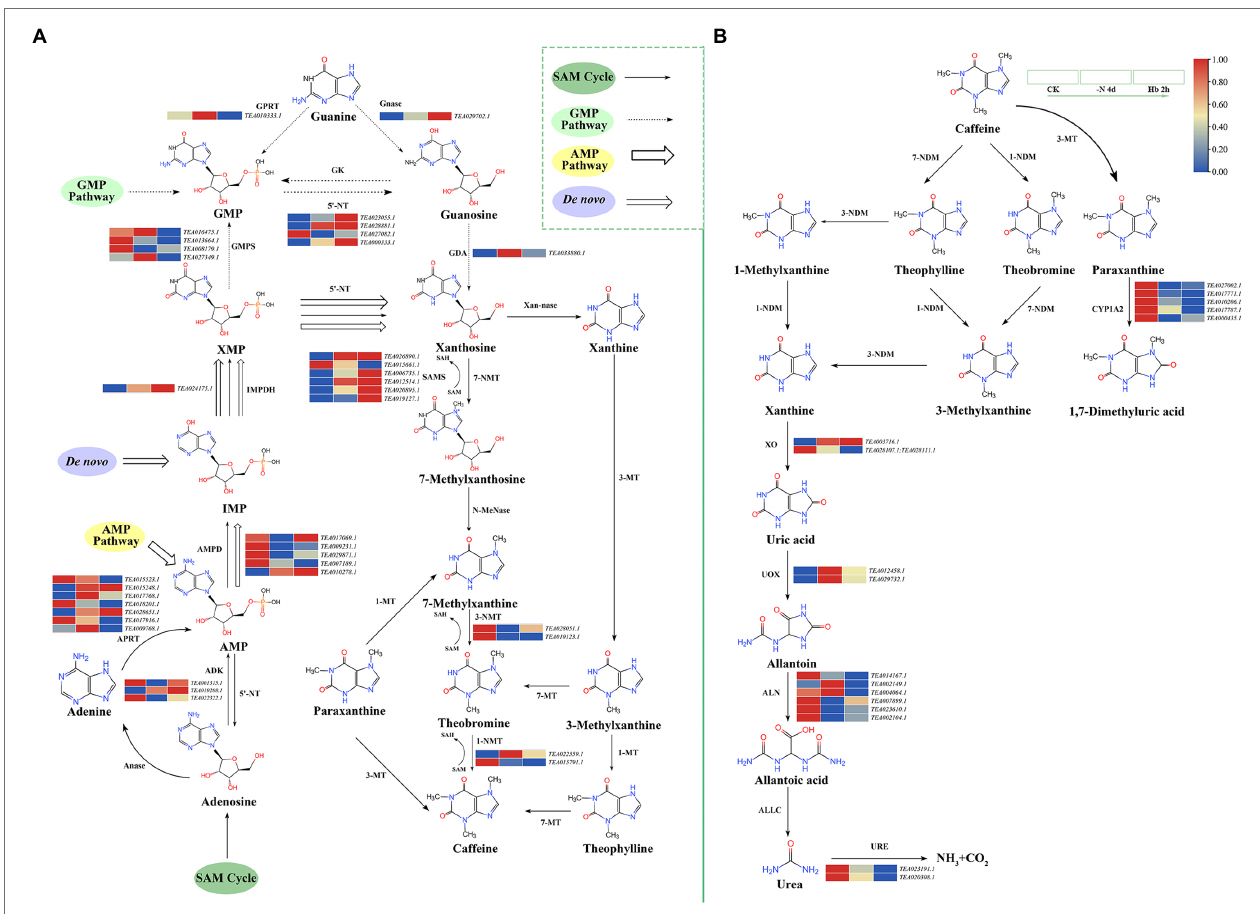
FIGURE 6 | Key gene expressions in the caffeine metabolic pathway in C. sinensis roots during N deprivation and resupply. (A) Caffeine synthesis pathway; (B) caffeine degradation. Relative expression levels are shown by a color gradient from low (blue) to high (red). Anase, adenosine nucleosidase; APRT, adenine phosphoribosyltransferase; N-MeNase, N-methyl nucleosidase; Xan-nase, xanthine nucleosidase; MT, methyltransferase; NDM, N-demethylase; ALLC,